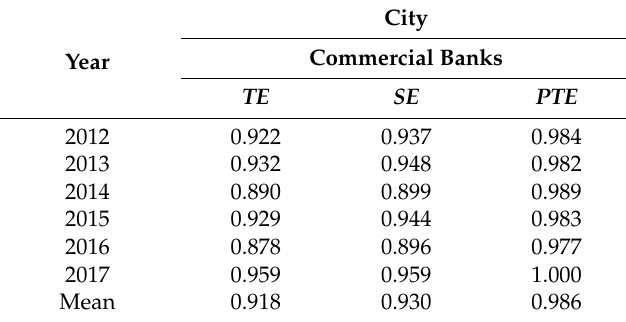
Table 10. The average efficiency of city commercial banks (2012–2017).